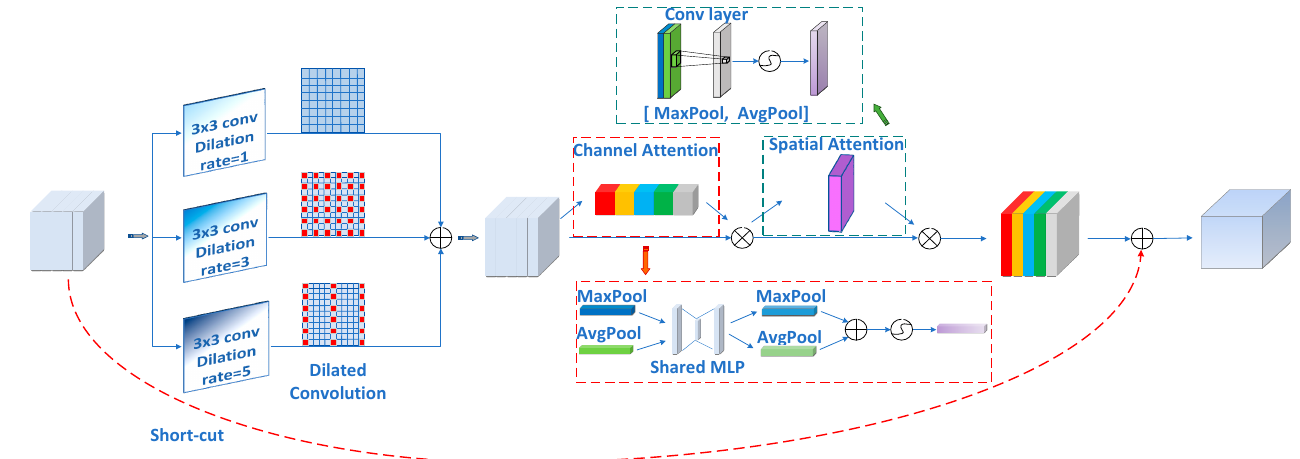
Figure 6. The schematic diagram of the DAMR architecture.